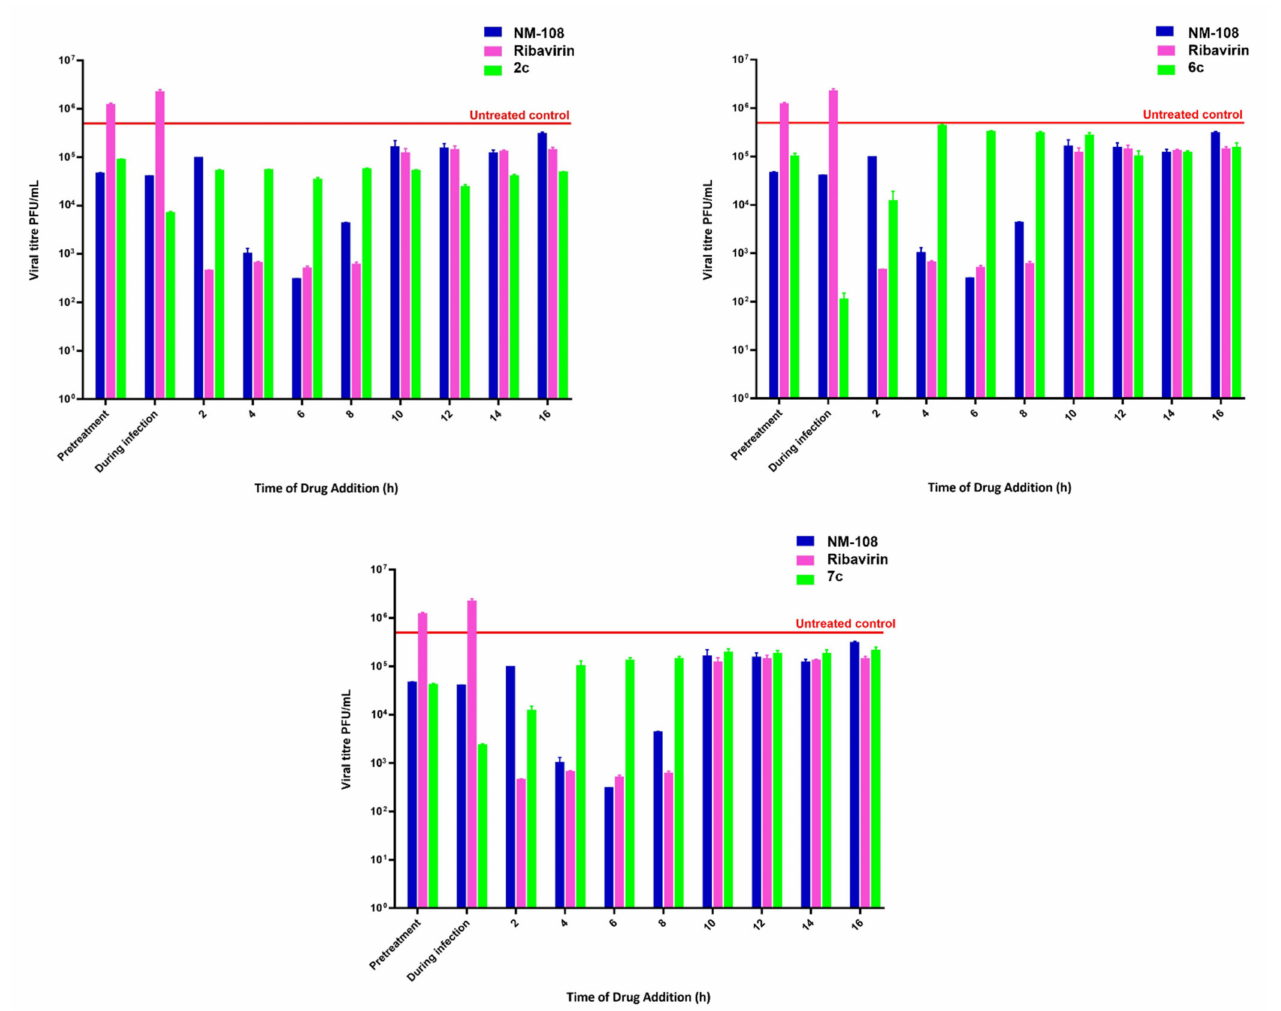
Figure 2. Effect of the time of drug addition on antiviral activity with SD of derivatives 2c (0.09 µ M), 6c (0.23 µ M) and 7c (0.3 µ M) (green). Parallel experiments were performed using reference com- pounds NM 108 (1.5 µ M) (blue) and Ribavirin (16 µ M) (purple) for comparison. We show the untreated control in